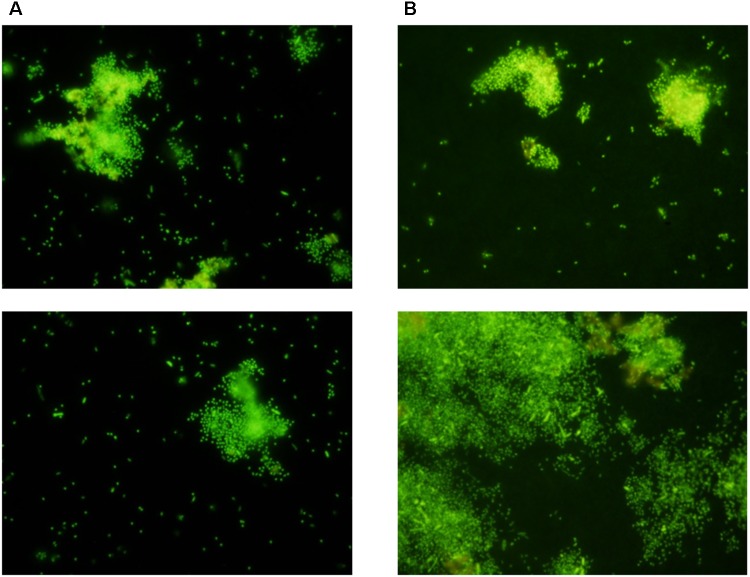
Random sections of SYBR stained membranes from negative controls with sterile f/2 medium in the inner chamber and P. inhibens DSM17395 outside the chamber. (A) Experimental membranes. (B) Control membranes.